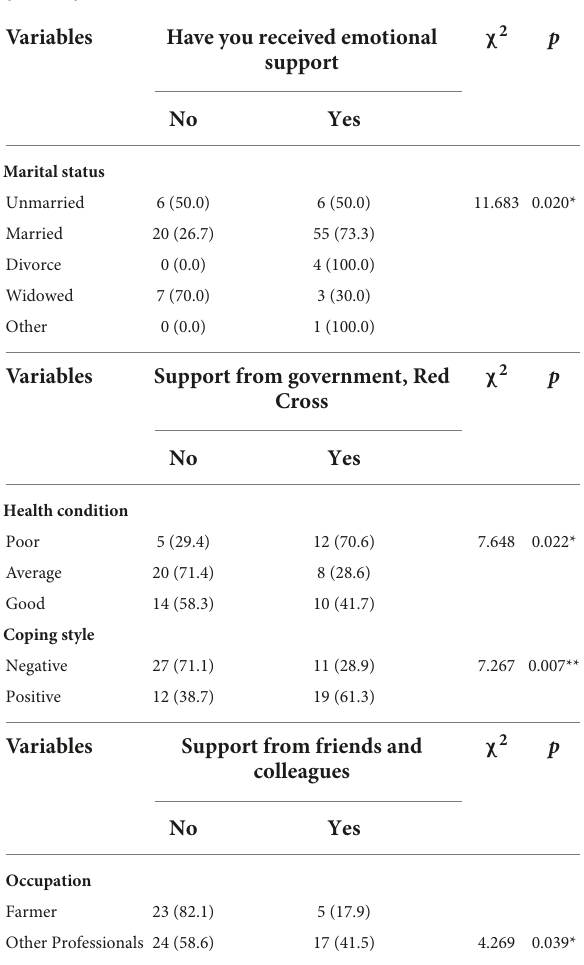
TABLE 4 Variance analysis of emotional support of respondents ( N =